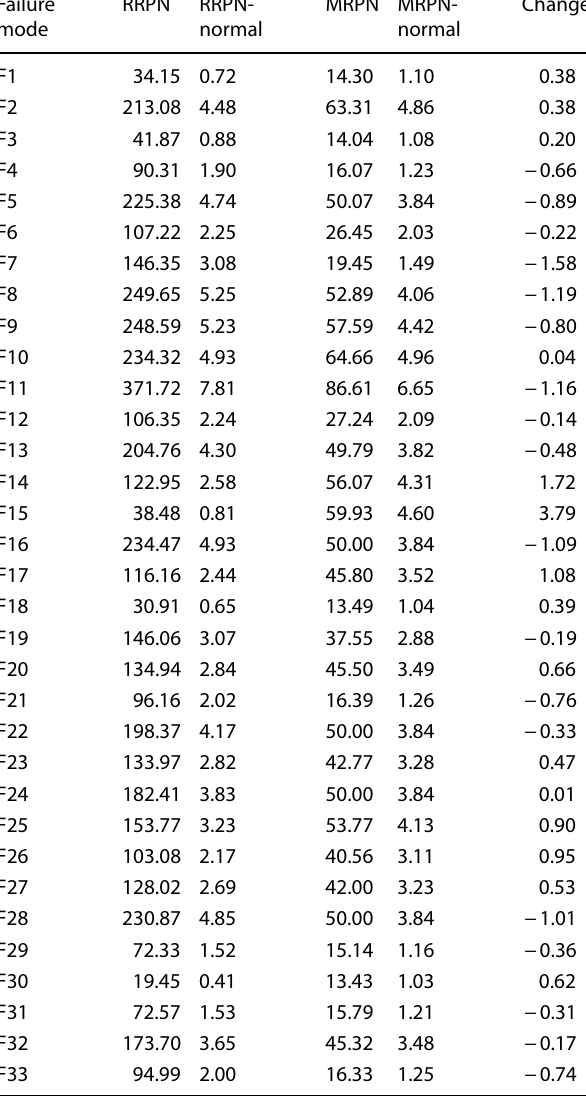
Table 12 Normalized change in values of RPN